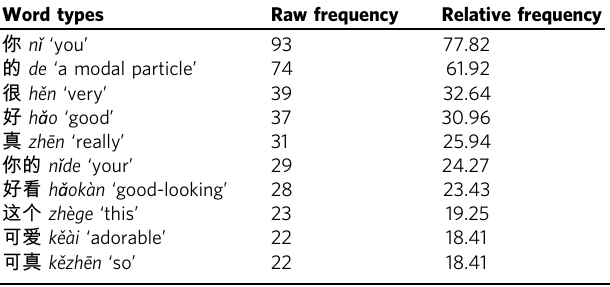
Table 5 Top 10 words in girls ’ normal speech. Word types